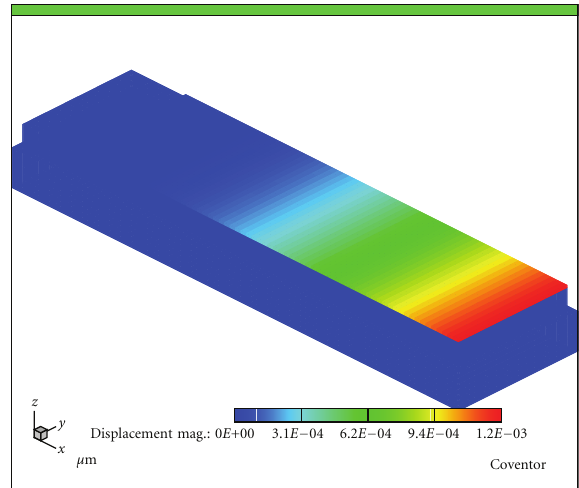
Figure 13: Top electrode deflection of the sensor when 0.1V is applied.